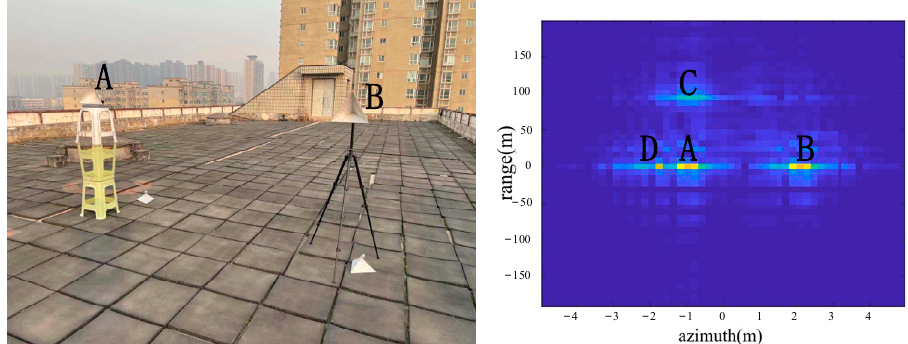
Figure 6. The 1st group of experimental scenes and imaging results.